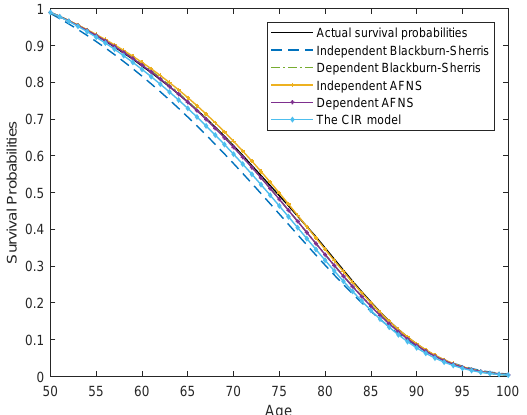
Figure 9. Actual and Best-Estimate Survival Probabilities of the 1916